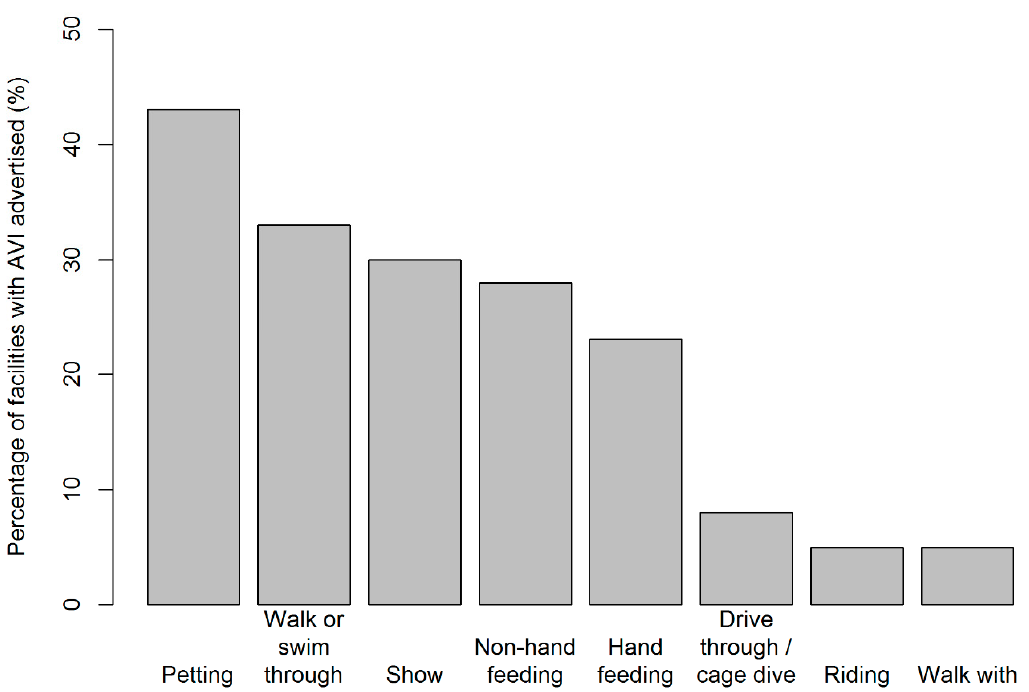
Figure 4. Percentage of facilities observed with each AVI type. Frequency of AVI type was found to be unevenly distributed across the facilities reviewed ( χ 2 = 830.56, df = 7, p < 0.001); with petting, walk or swim through, show, non-hand feeding, and hand feeding found to occur more frequently than expected.